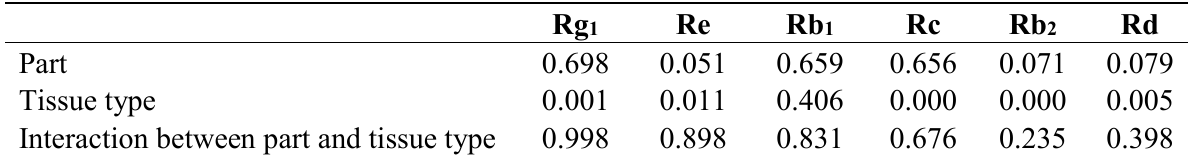
Table 1. Summary of p values of the analysis of variance of ginsenoside contents in healthy ginseng roots.